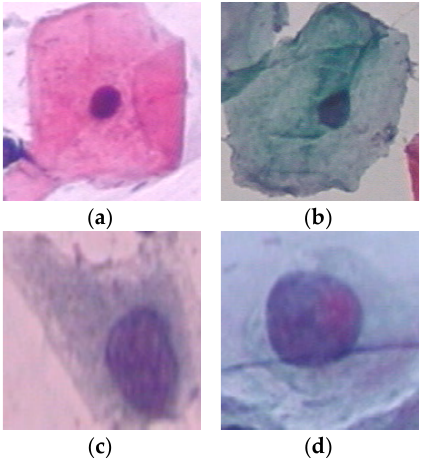
Figure 1. Some samples of cervix cells from the Herlev dataset [3]. ( a ) Normal cell (normal superficial class); ( b ) Normal cell (intermediate class); ( c ) Abnormal cell (severe dysplastic class); ( d ) Abnormal cell (moderate dysplastic class).